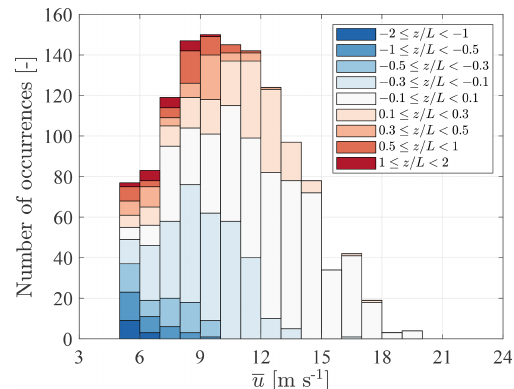
Figure 6. Stability distribution as a function of mean wind speed for the considered fetches (220–330 ◦ ) at height z =